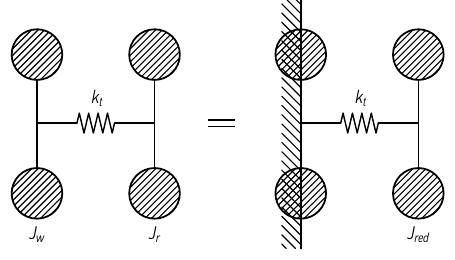
Fig. 7. The principle of determining the 2nd eigenfrequency – the wheelset is regarded as free and both masses oscillate against each